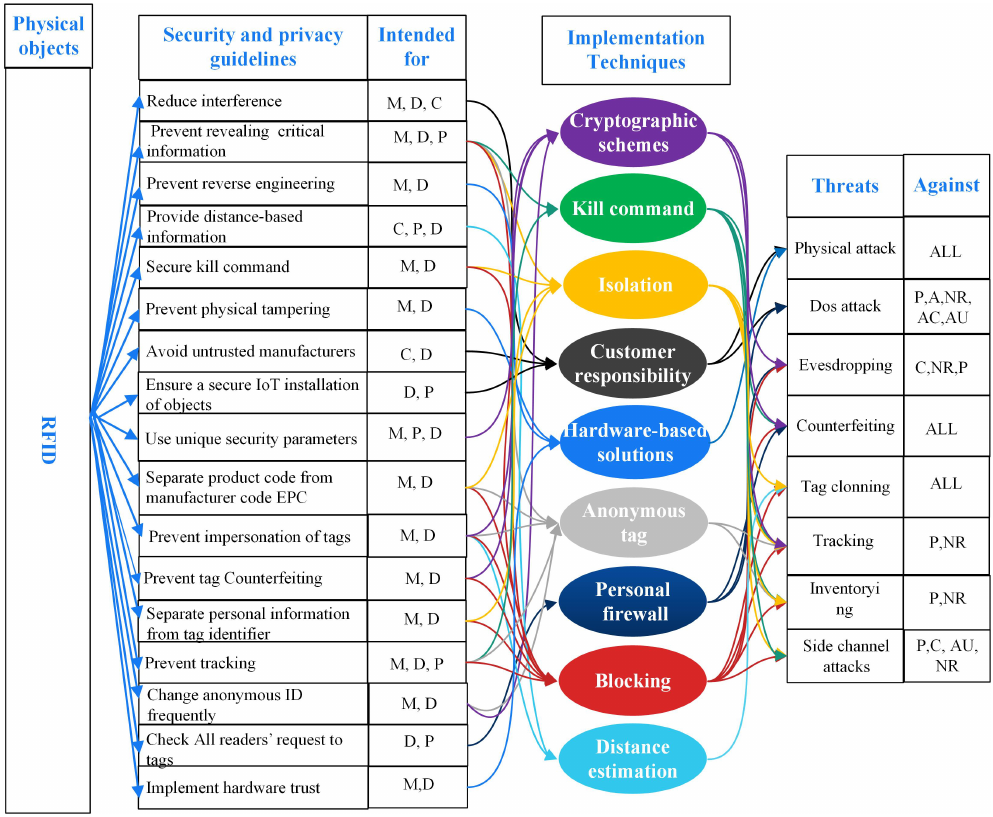
Figure 3. An overview of guidelines, stakeholders, attacks and countermeasures for Radio-Frequency Identification (RFID) tags.